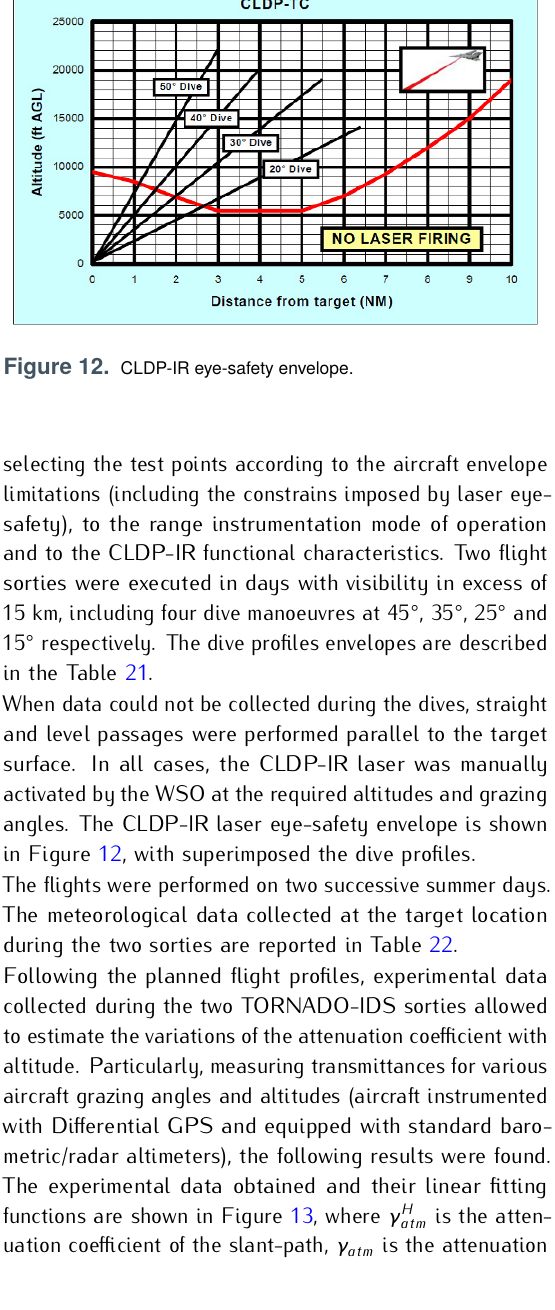
Table 17. Calculated extinction coefficients for dry-air.